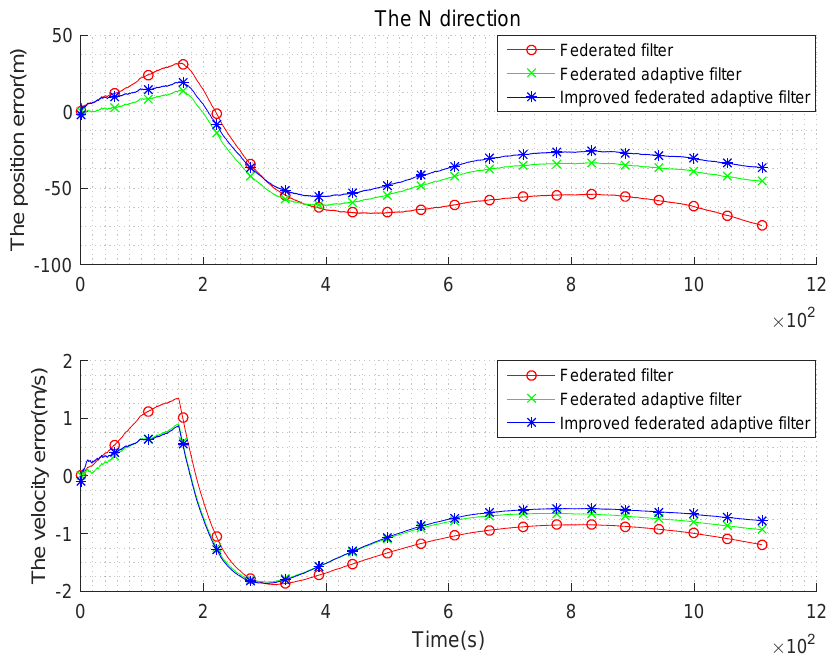
Figure 11. Comparison of the navigation error with non-Gaussian state noise and biased estimation in N